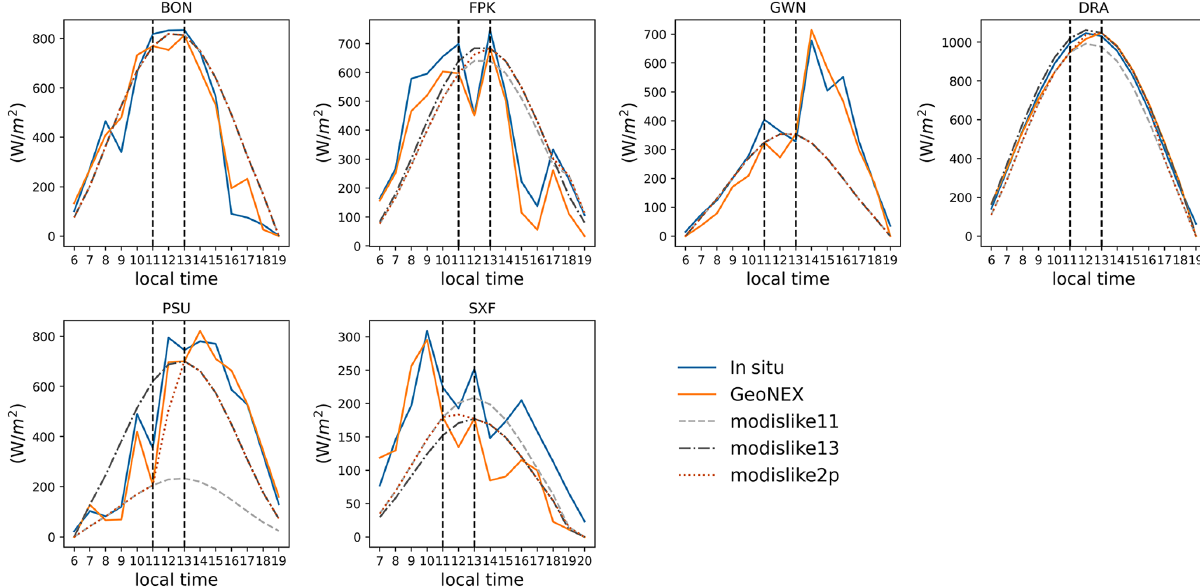
Figure 13. Comparison of hourly DSR between the GeoNEX product and the MODIS-interpolated data over seven SURFRAD stations on 19